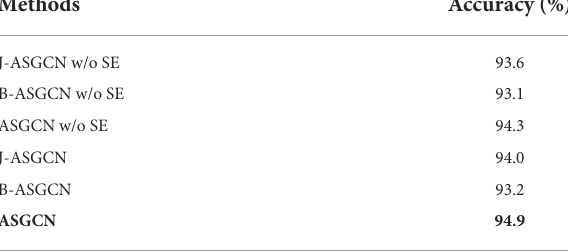
TABLE 4 Comparison of spatial graph convolution layer with and without SE block on the Filtered NTU RGB+D dataset.